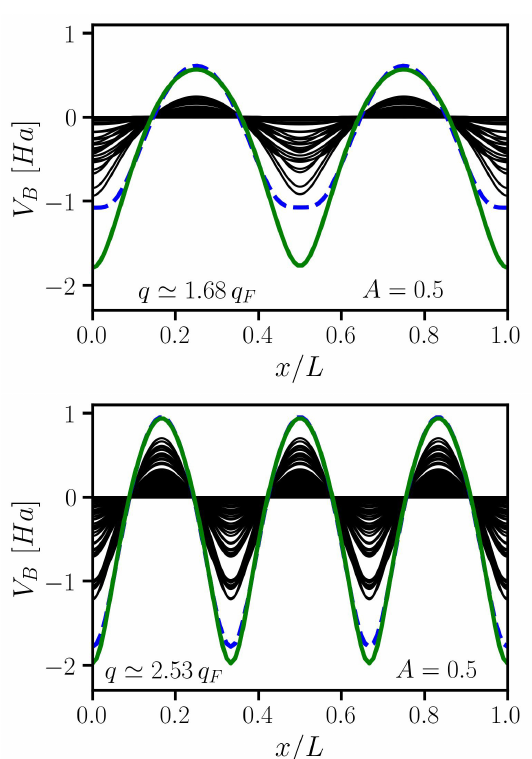
Figure 9: Comparison of the quantum Bohm potentials at q (cid:39) 1.68 q (top panel) F = 2 and θ = 1), where we illustrate the stan- and at q (cid:39) 2.53 q (bottom panel) ( r F s dard Bohm potential (dashed blue) and the many-fermion quantum Bohm potential (green). We also illustrate the contribution of the orbitals (black) scaled by the factor five (twelve) in the top (bottom) panel.